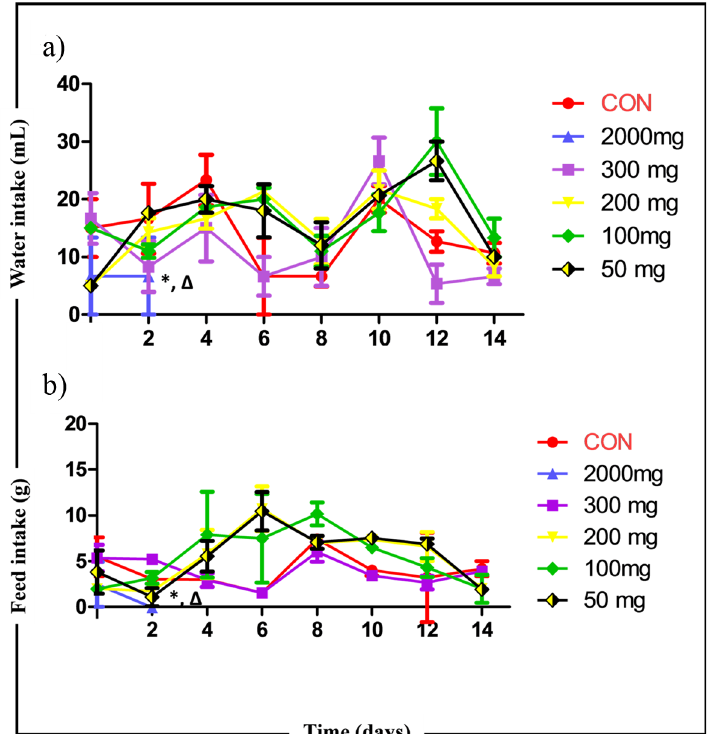
Figure 3. Evaluation of water and feed consumption of animals treated with different doses of aqueous extract from leaves of M. ferruginata